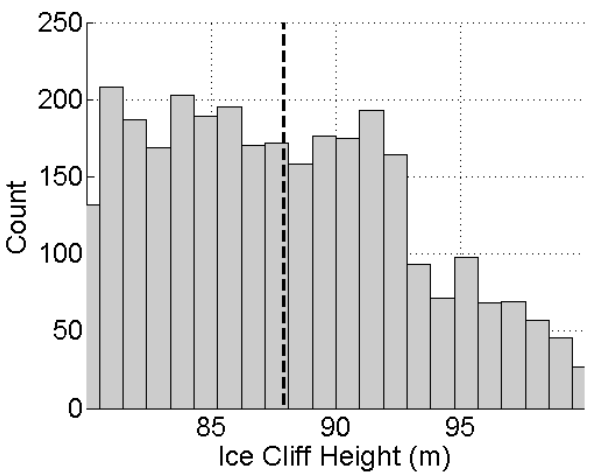
Fig. 9. Prescribed terminus ice cliff height in the selected ensemble of simulations. Dashed line denotes the ensemble mean